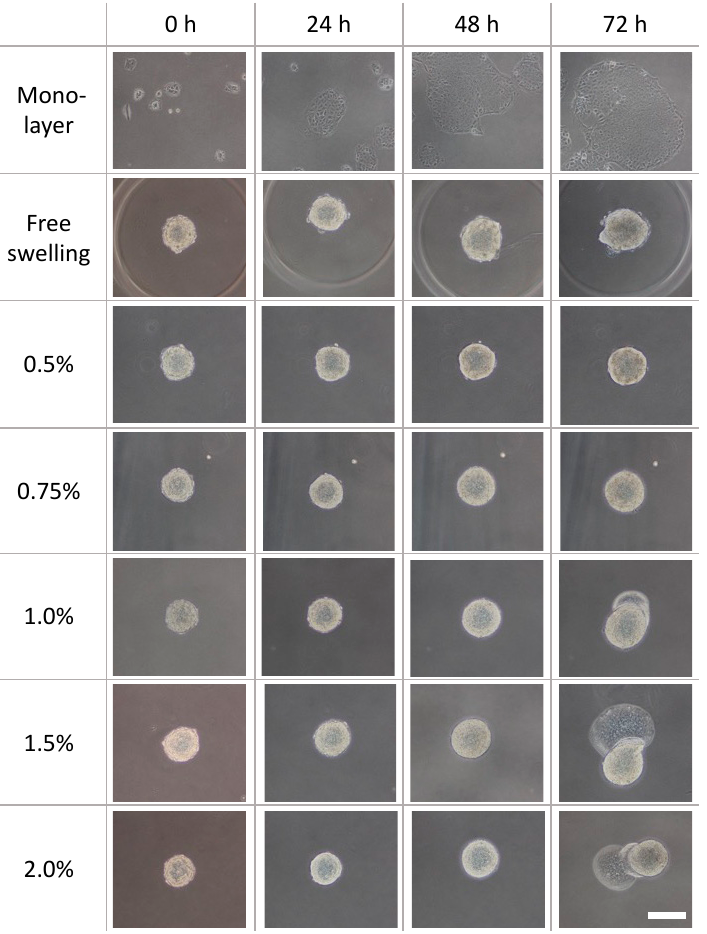
Figure 5. Phase-contrast images of the DLD-1 cell spheroids cultured in agarose gels with different mass concentrations. Scale bar: 200 µm.